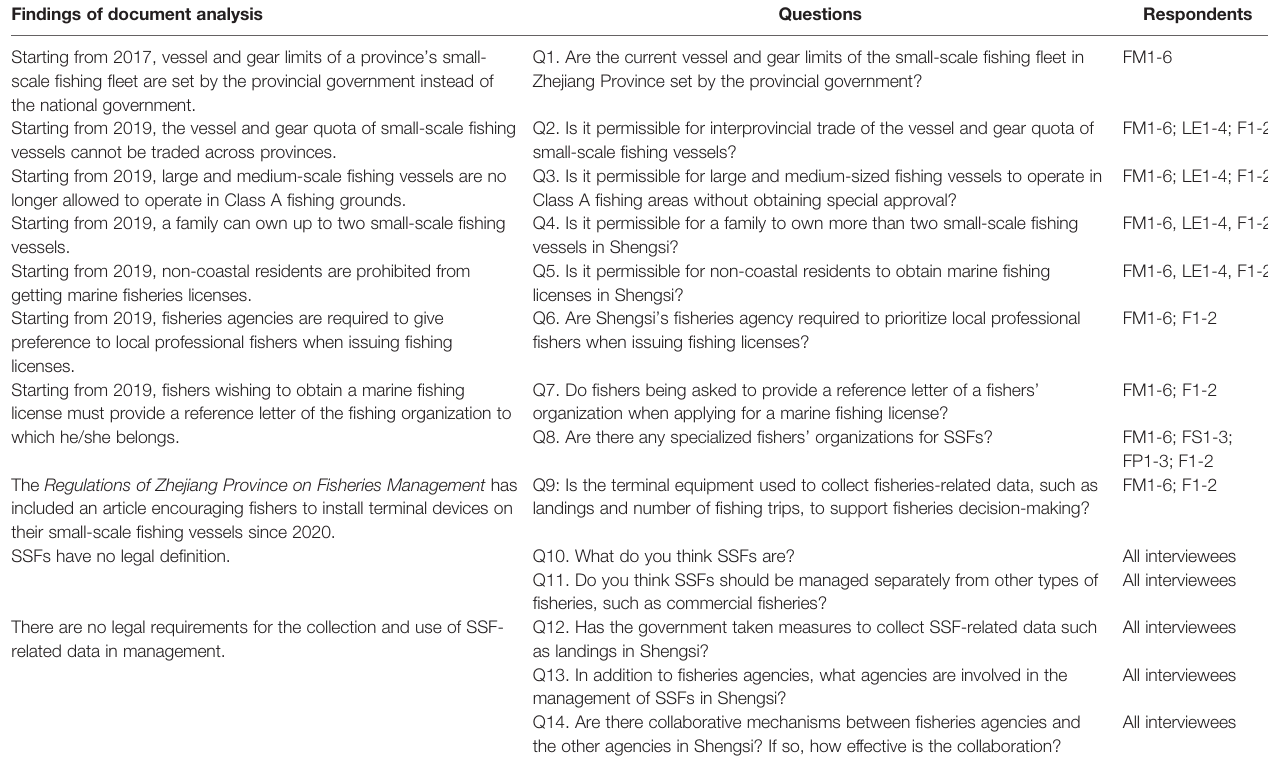
Findings of document